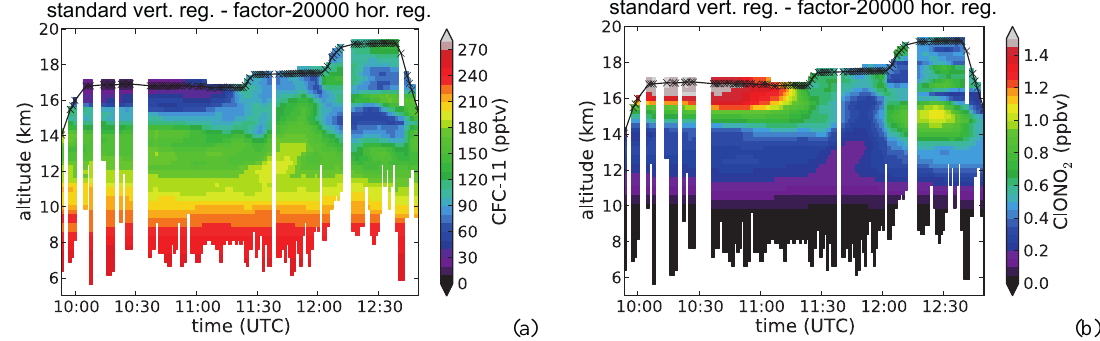
Fig. 5. Two cross-sections of CFC-11 (a) and ClONO 2 (b) volume mixing ratios with standard vertical regularisation and factor-20000 horizontal regularisation.